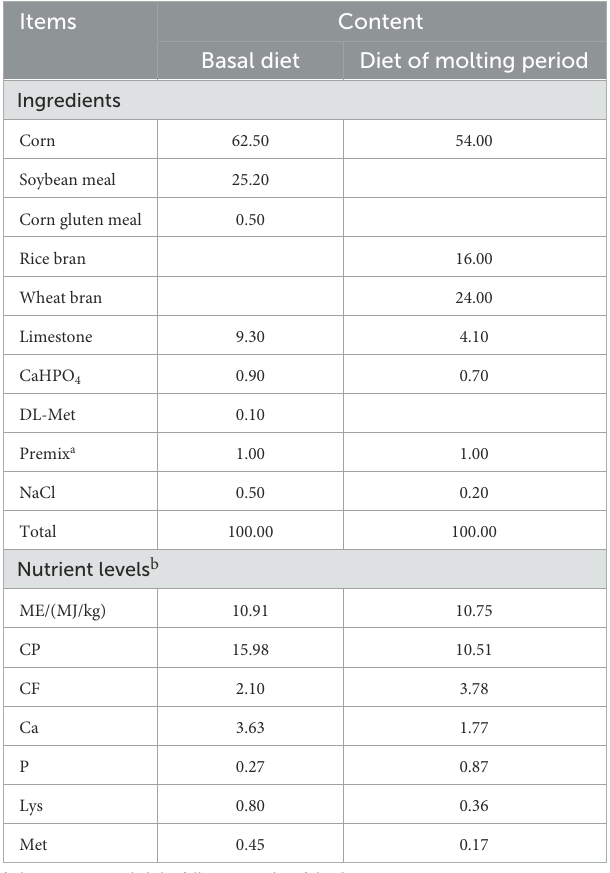
TABLE 1 Ingredients and chemical composition of basal